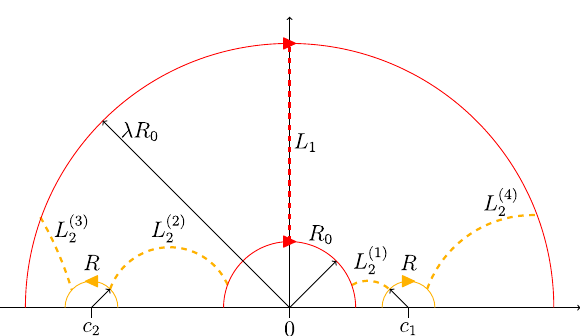
Fig. 13 The fundamental domain of the ( 1 , 1 ) Riemann surface. The color-coded dashed lines L 1 , 2 are non-intersecting periodic geodesics. Inthissystem,twoofthephysicalparametersarelengthsoftheminimal periodic geodesic, while the third physical parameter is a twist . This picture is taken from [75]